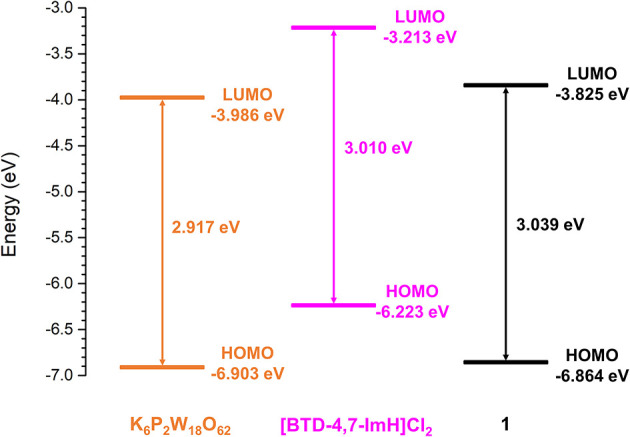
Derived frontier orbital energies for K6P2W18O62, [BTD-4,7-ImH]Cl2, and 1.